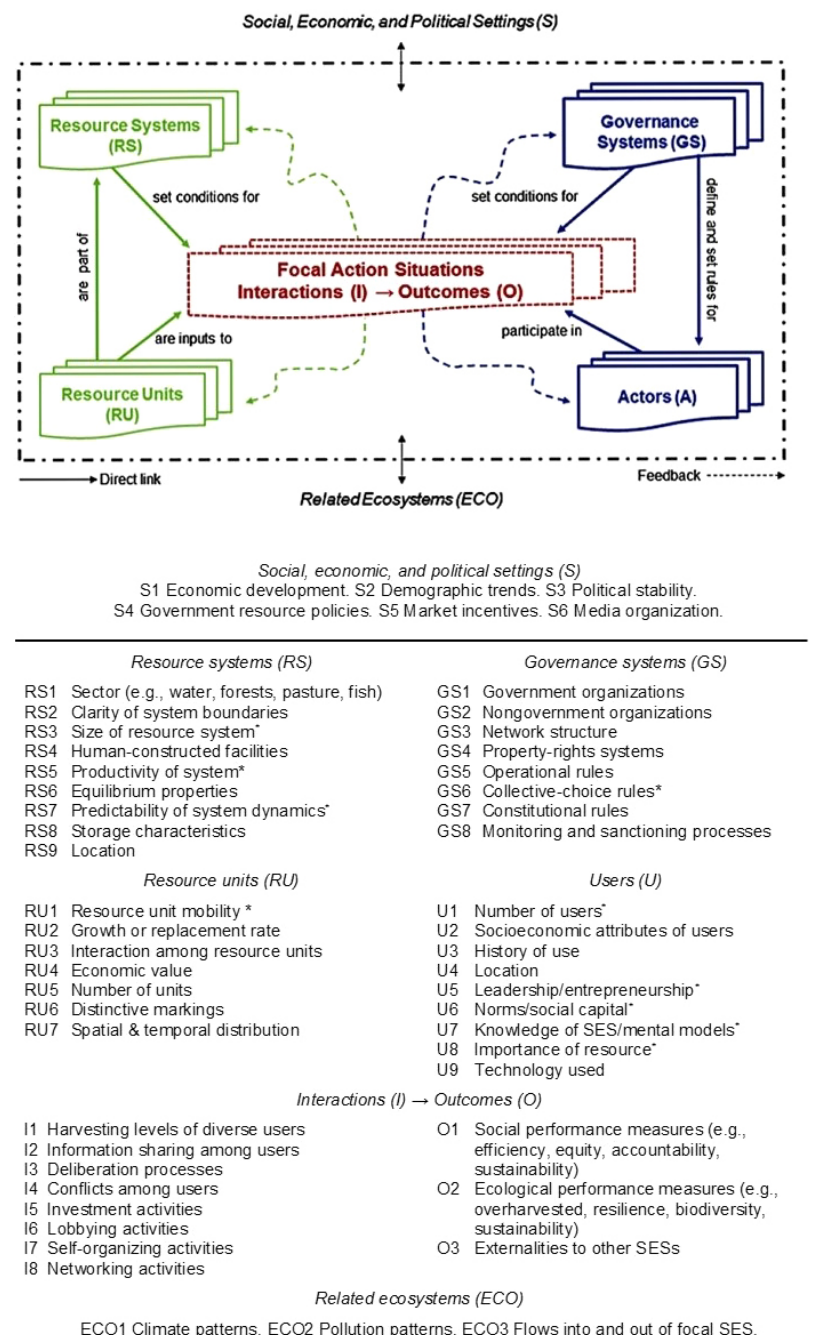
Fig. 4 . Ostrom action situation and social-ecological system framework. Analytical framework for understanding dynamic environmental governance processes in complex social-ecological systems (SESs), or particular centers of activity, analogous to the Adaptive Water Governance Project’s Emergence Frontiers convention (Fig. 2), and associated SESs approach. Listed variables indicate categories, and specific instances, of SESs that may shape environmental governance. Source: Reprinted with permission from McGinnis and Ostrom (2014), Ostrom (2009), and The American Association for the Advancement of